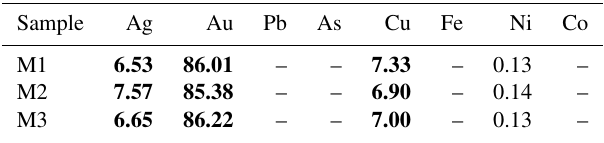
reliquary crown of